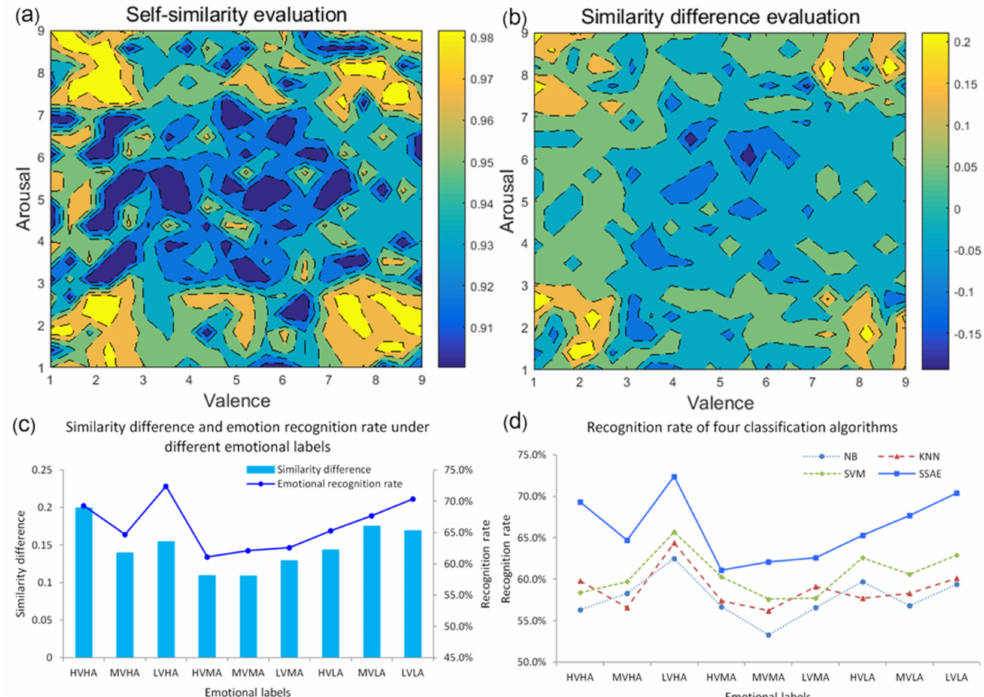
Figure 8. Relationship between self-similarity, similarity difference, and emotional recognition rate: ( a , b ) show the distribution of self-similarity and similarity difference in the V–A plane, respectively. ( c ) shows the variation trend of similarity difference and emotion recognition rate under different emotional labels; and ( d ) shows the recognition and comparison results of four commonly used emotion classification